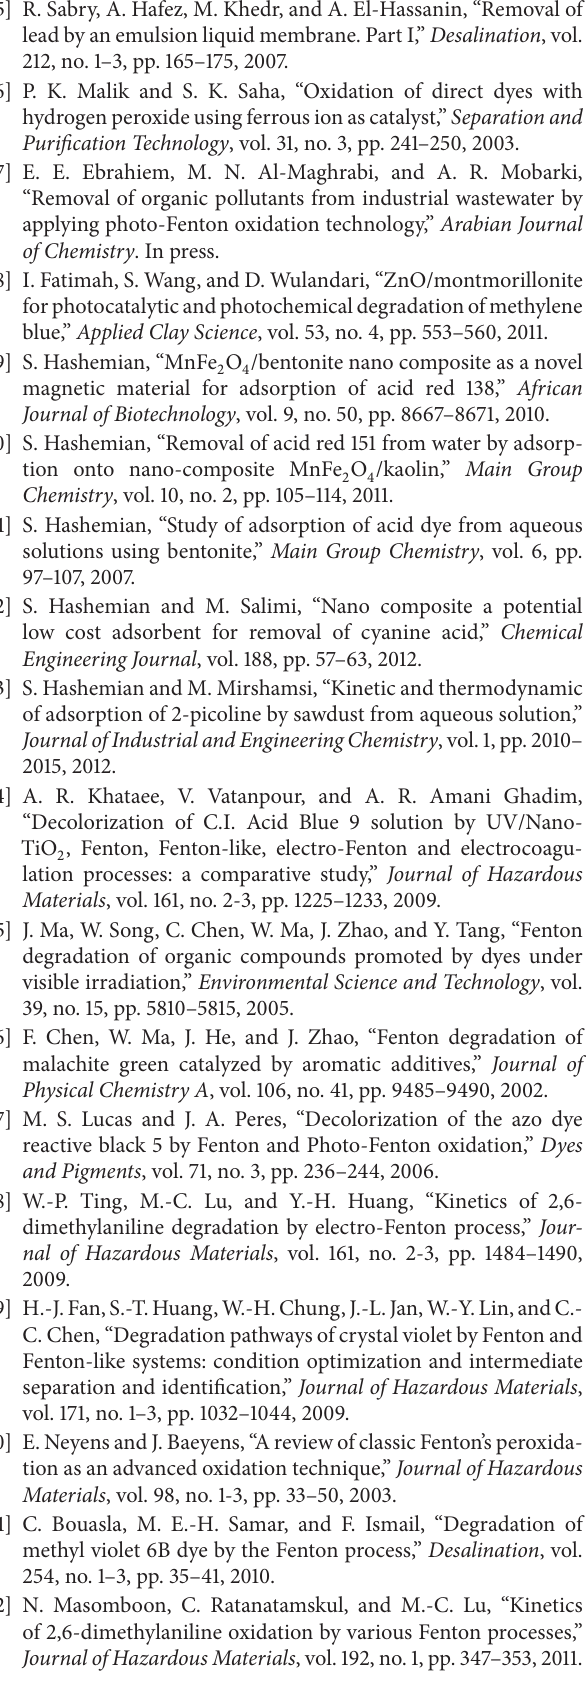
Table 1: Thermodynamic parameters for Fenton oxidation of